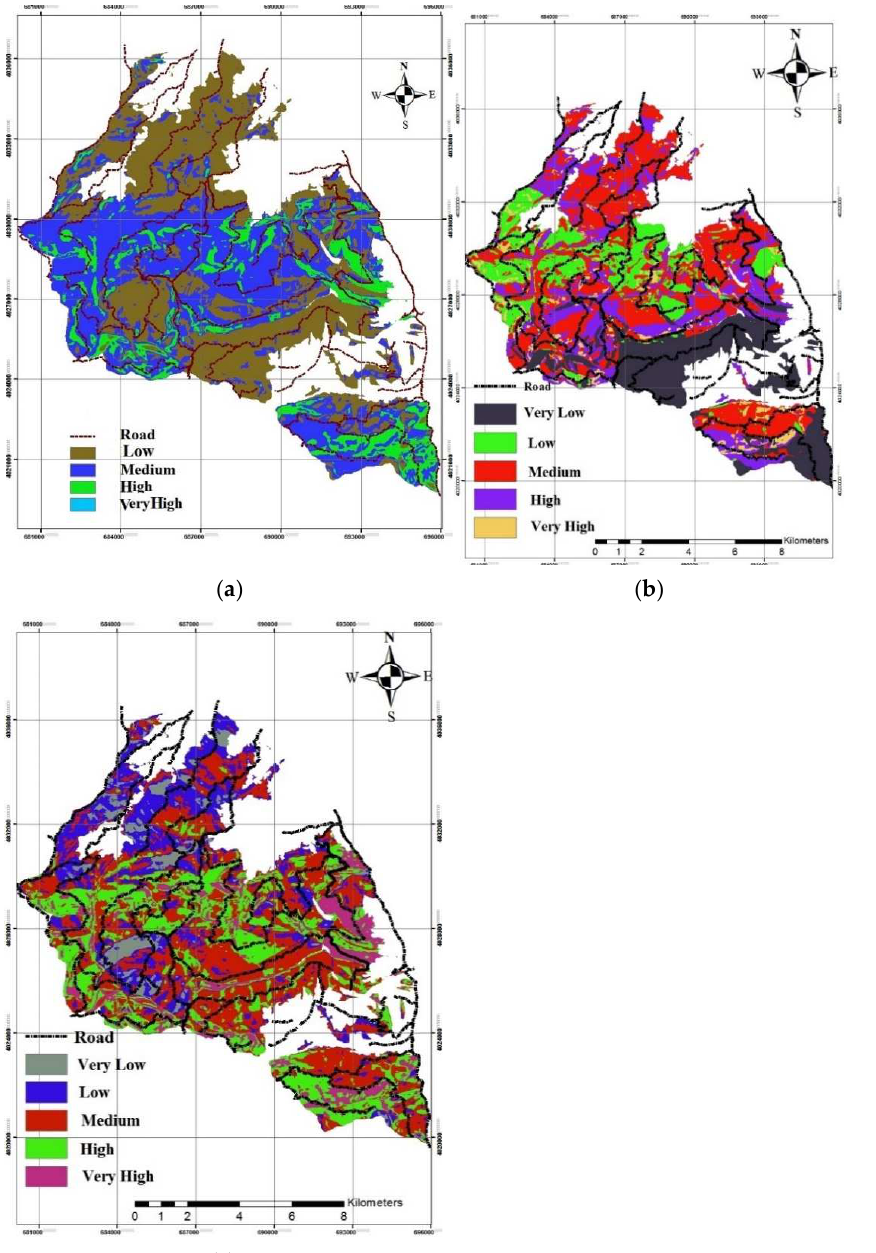
( c ) Figure 5. Receiver operating characteristics (ROC) curve showing the area under curve for the landslide susceptibility maps produced using various MFs in ANFIS based models and Frequency ratio model: ( a ) AUC = 68.8%; ( b ) AUC = 67.8%; ( c ) AUC = 70.7%.